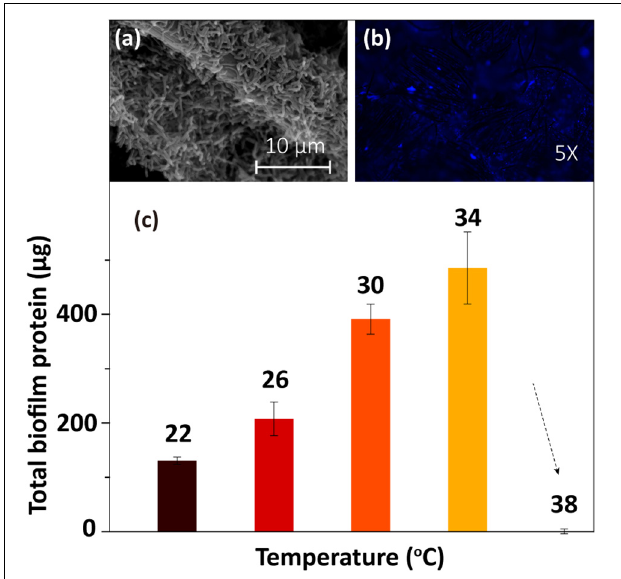
FIGURE 2 | Biofilm morphology at 30 ◦ C: (a) SEM image and (b) fluorescence microscopy image. (c) Total biofilm protein at different temperatures.